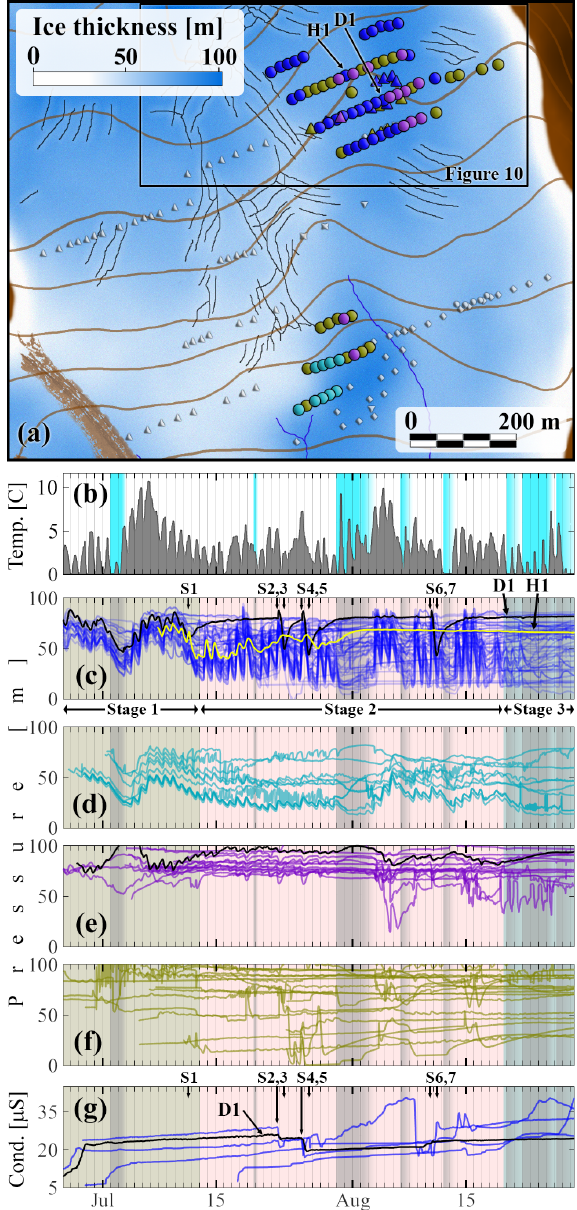
Figure 9. Locations and pressure time series for all 82 boreholes on the plateau area and 20 boreholes down-glacier during June– August 2015, plotted using the same scheme as Fig. 5. (b) Temper- atures (grey) and fresh snow cover (light blue), (c) pressure in 42 boreholes on the plateau that shared similar water pressure varia- tions. The highlighted time series are from boreholes D1 (black) and H1 (yellow). Both boreholes are indicated on the map. S1–S7 indi- cate “switching events” in the D1 record (see Sect. 3.4). (d) Bore- holes downstream of the plateau showing similar pressure variation to those in panel (b) . (e) Pressure records that are anti-correlated to those on panels (c) – (d) . (f) Pressure records from the remaining boreholes on the map, (g) conductivity records from the six digital sensors included in panel (c) .